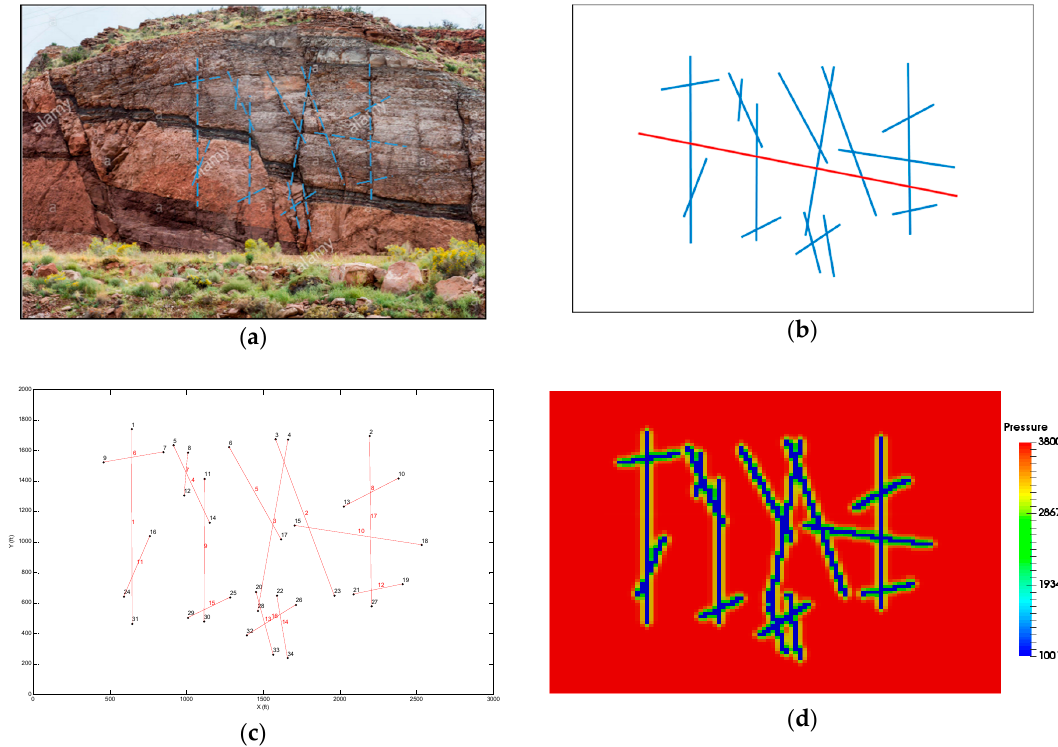
Figure 6. Field fracture outcrop case in Utah, USA. ( a ) A network of faults and fractures in a rock outcrop. Southern Utah, USA [46]; ( b ) fracture network pattern (blue lines) and well location (red line) (range length:height = 3:2); ( c ) fracture nodes and line segment detection results; ( d ) the pressure profile after 3 years production.